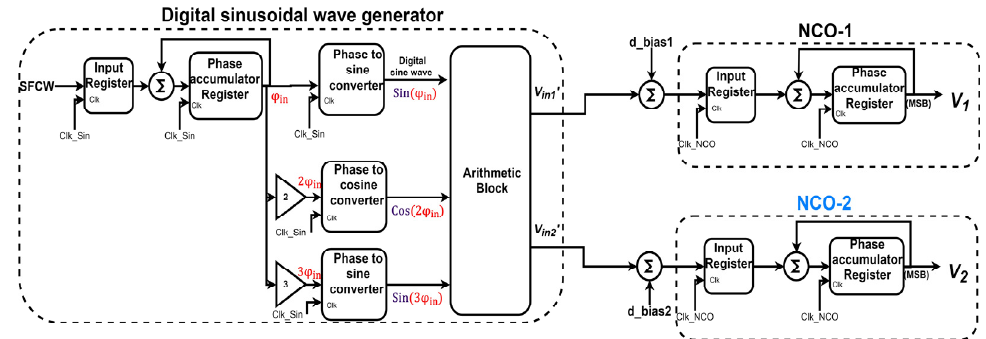
Figure 7. Hardware emulation of two VCOs modulated by a differential sinusoidal voltage.